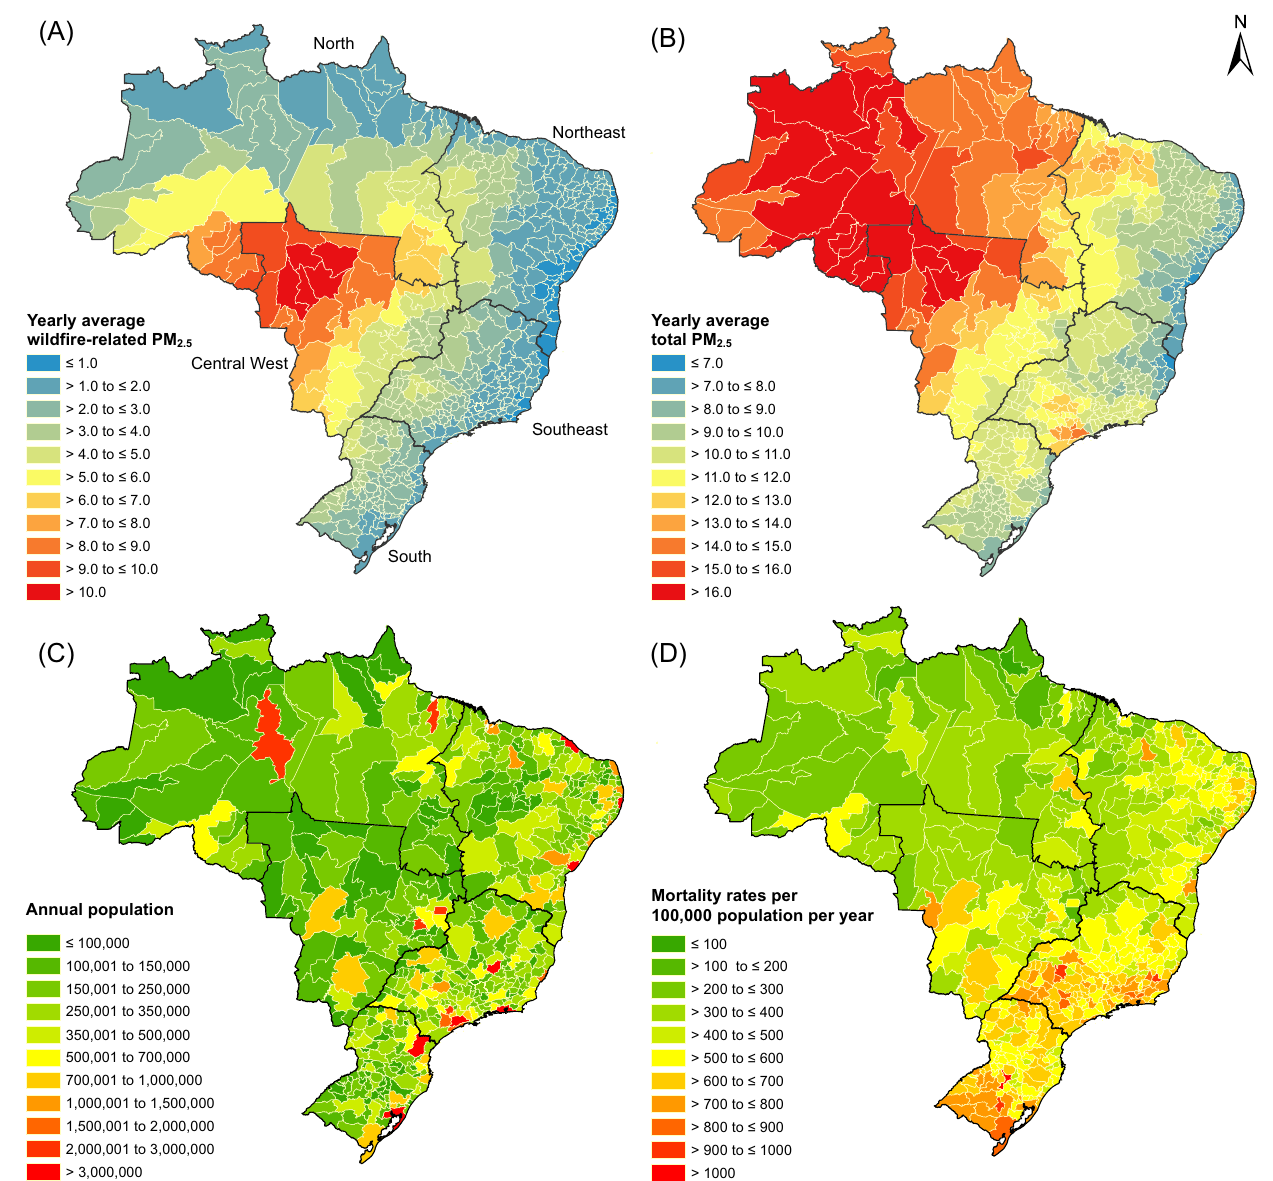
Fig. 1 | Spatial variations in air pollutants, population, and mortality rates in Brazil. There are regional differences in ( A ) yearly average wild fi re-related PM 2.5